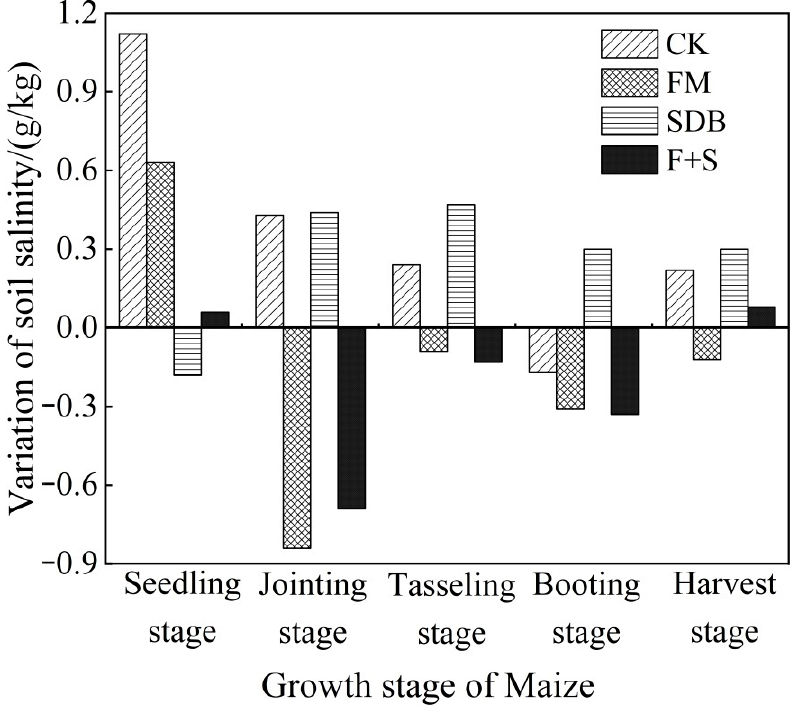
Figure 2. The soil salinity dynamics in root depth during each growth stage.